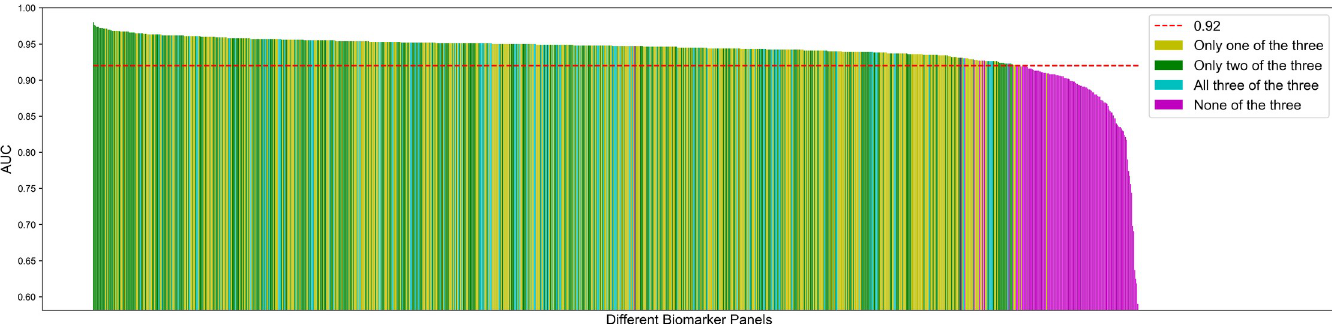
Fig 6. Classifiers using lung protein biomarker candidates CXCL1, CXCL2, or MMP8 have the highest performance. Bar chart of 5-fold-cross validation AUC of 1023 different biomarker panels sorted in descending order. Y-axis denotes the AUC and each bar in the x-axis corresponds to a different panel. Yellow, green and teal bars indicate the classifiers using any one of the three lung protein biomarker candidates, any two of the three, and all three respectively. Magenta bars indicate the classifiers that did not include CXCL1, CXCL2 or MMP8. Classifiers that did not include CXCL1, CXCL2, or MMP8 all had AUCs lower than 0.92, the red dashed line.